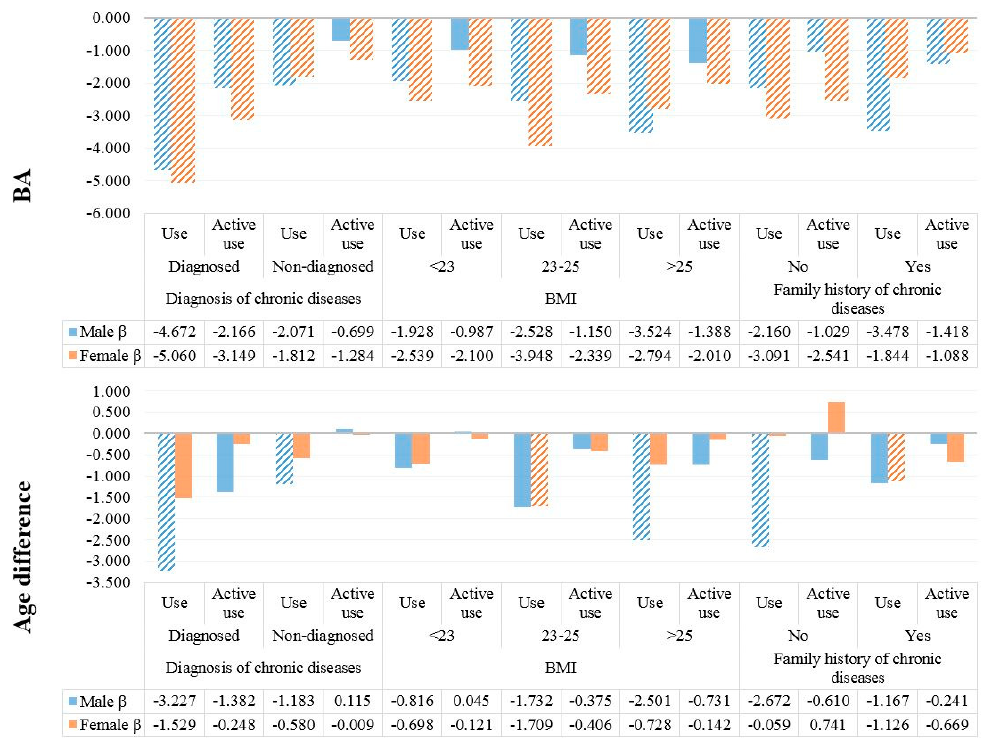
Figure 2. Subgroup linear regression analyses exploring associations between the use of nutrition data and BA and BA–CA by clinical status. Marked plot mean statistically significant ( p < 0.05).